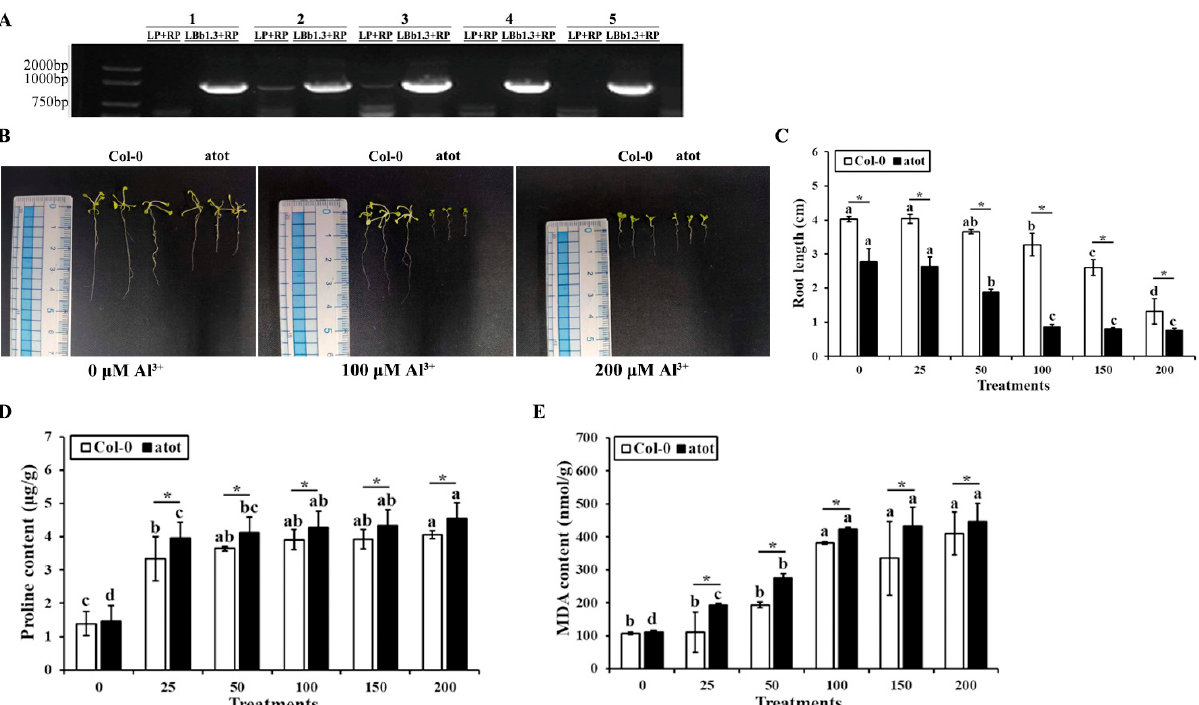
Figure 4. Effects of aluminum on the wild-type and atot mutant Arabidopsis . ( A ) Confirmation of the homozygosity of the atot mutant plants. Information on the atot mutant (SALK_002559C) can be found at http://signal.salk.edu/cgi-bin/tdnaexpress/ (accessed on 7 January 2022), and plants no. 1, 4, and 5 which showed a clear band for the LBb1.3 + RP primers but no bands for the LP + RP primers in the three primers PCR method were identified as homozygotes and utilized for the subsequent experiments. ( B ) Phenotype of the wild-type Col-0 and atot mutant under 0 (CK), 100, and 200 µ M Al 3+ for 2 weeks. ( C ) Root length comparison of the wild-type Col-0 and atot mutant under 0 (CK), 25, 50, 100, 150, and 200 µ M Al 3+ for 2 weeks. ( D ) Proline content of the wild-type Col-0 and atot mutant under 0 (CK), 25, 50, 100, 150, and 200 µ M Al 3+ . ( E ) Malonaldehyde content of the wild-type Col-0 and atot mutant under 0 (CK), 25, 50, 100, 150, and 200 µ M Al 3+ . Different letters above the bars indicate significant differences among the treatment concentrations and the asterisk (*) represents significant differences between the wild-type Col-0 and atot mutant Arabidopsis at p < 0.05.